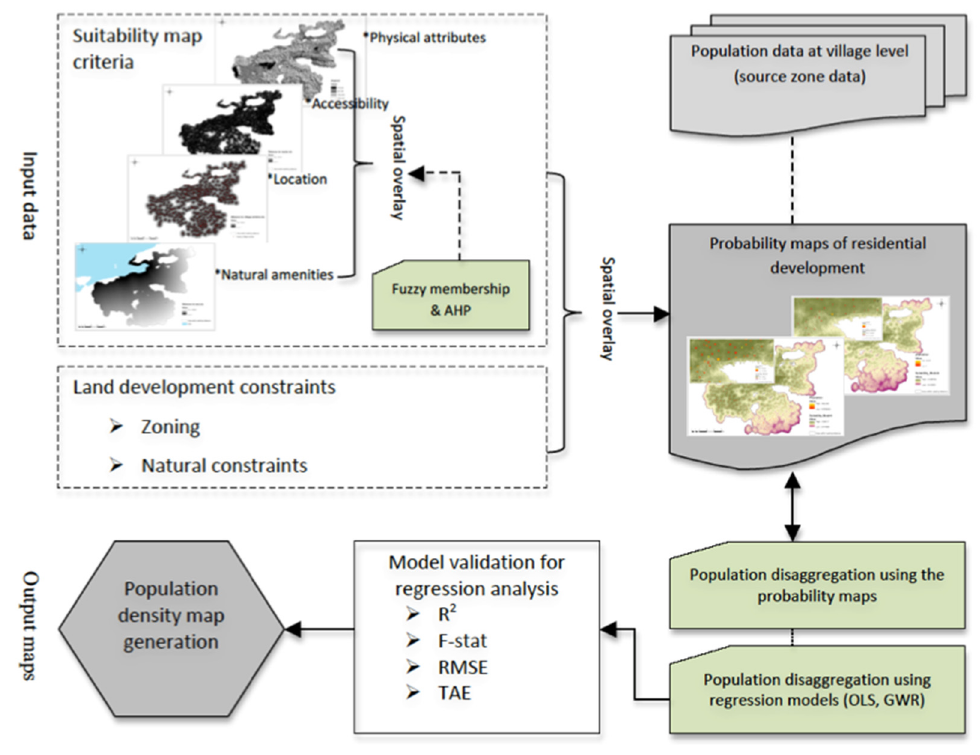
Figure 3. Flowchart for residential land cover and population map